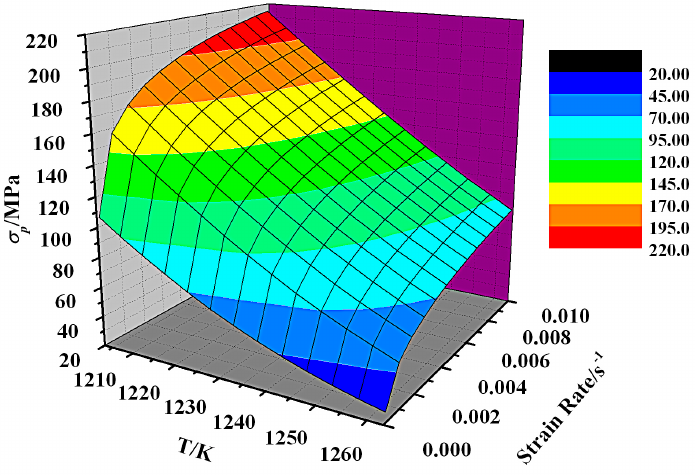
Figure 3. Plot of ln Figure 3. Plot of